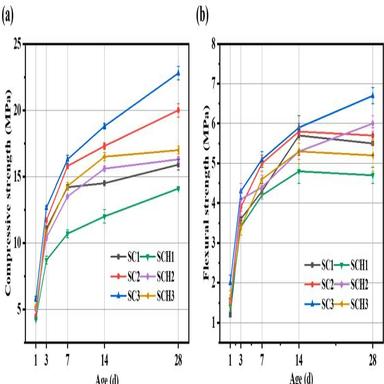
Strength development of mortar with different activators: (a) Compressive strength of mortar with different activators; (b) Flexural strength of mortar with different activators.